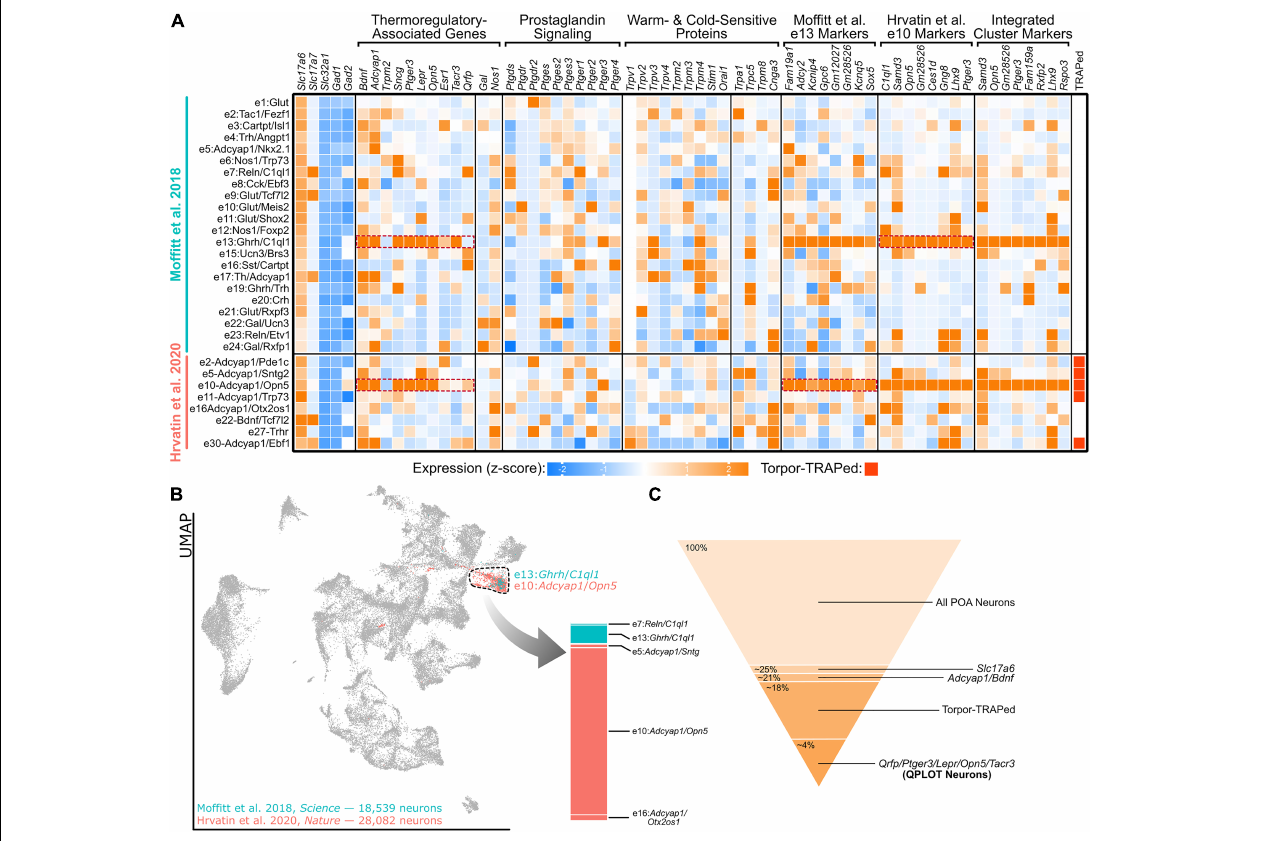
FIGURE 1 | A single molecular identity for QPLOT neurons. (A) Heatmap of excitatory POA neurons from Moffitt et al. (2018) and Hrvatin et al. (2020) Known marker genes for thermoregulatory POA neurons, prostaglandin-associated genes, and temperature-sensitive proteins are indicated in columns. Additionally, the top 8 marker genes for excitatory cluster 13 (e13) from Moffitt et al. (2018) and excitatory cluster 10 (e10) from Hrvatin et al. (2020) are provided as well as marker genes for the indicated cluster representing QPLOT neurons when the datasets are merged. Clusters identified in Torpor-TRAP experiments (Hrvatin et al., 2020 clusters only) are indicated. Data is represented as relative expression of each gene within the cluster, averaged over all neuronal clusters, including inhibitory neurons (shown in Supplementary Figure 1 ). (B) Uniform manifold projection of 46,621 POA neurons integrated with Seurat v3 (Stuart et al., 2019). Cluster 16, the cluster containing QPLOT neurons, is indicated by the dashed black line. The QPLOT neuron cluster is composed predominantly of e13 from Moffitt et al. (2018) and e10 from Hrvatin et al. (2020) (C) Summary of neuronal populations within the POA that are sufficient to reduce body temperature and thermogenesis ( Supplementary Figure 2